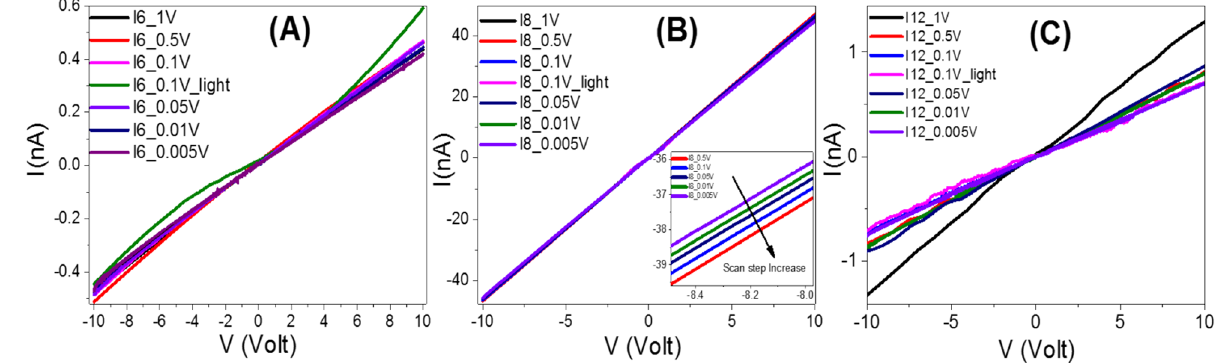
Figure 9. Electrical voltage-current characteristics of ( A ) I-6 , ( B ) I-10 , and ( C ) I-12 samples in liquid crystal phase designed at 140 °C.